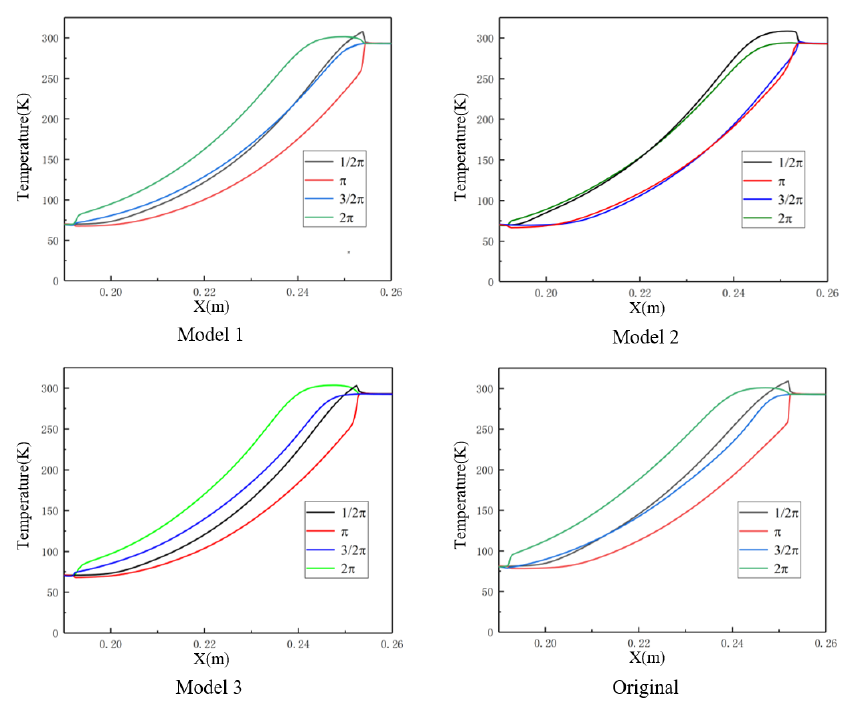
Figure 4. Axial temperature variation of the pulse